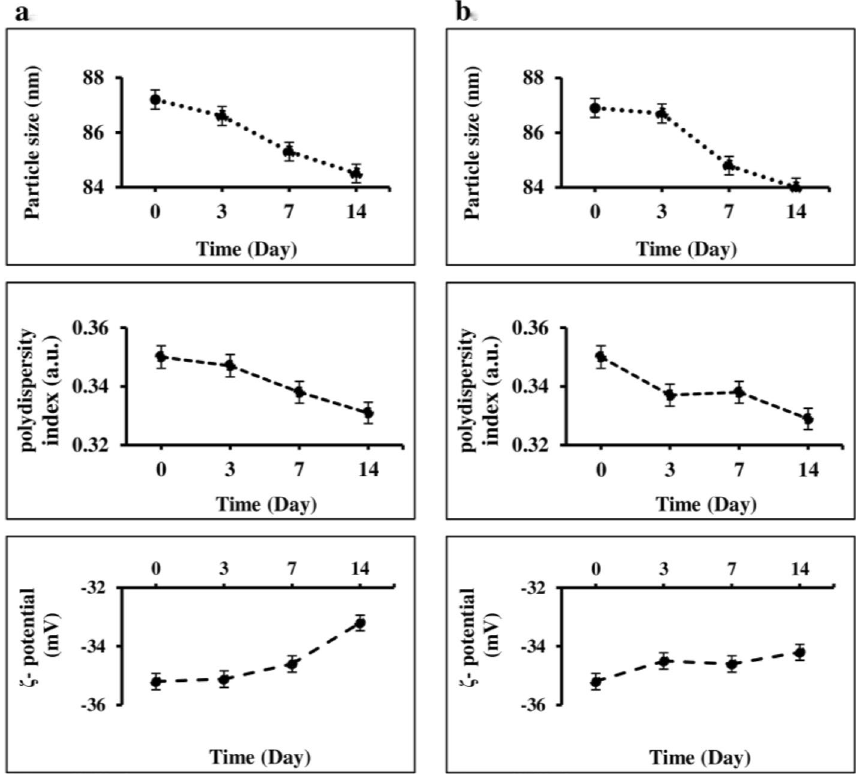
Figure 3. Particle size, polydispersity index, and ζ-potential of Cur-NPhs in different conditions; ( a ) at 4 °C, ( b ) at 37 °C.